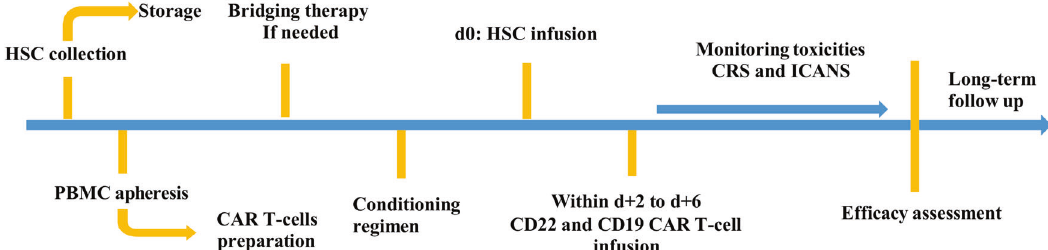
Fig. 1 Therapy procedure. All eligible CNSL patients underwent two separate apheresis, and received conditioning regimen before HSC infusion on d0, two separate CAR T-cell products (CD22 and CD19 CAR T-cells) were infused within the range of 2 – 6 days (d + 2 to d + 6) after HSC